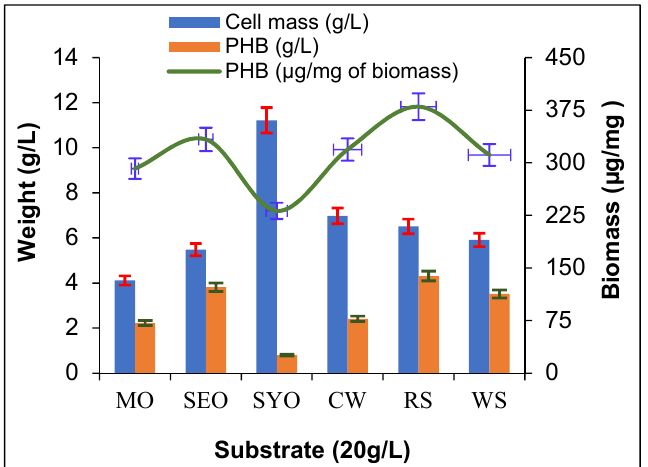
Figure 4. PHB accumulation in A. faecalis RZS4 during 24 h growth at 30 °C and 120 rpm in NDM amended with crude vegetable oil and agro-wastes (20 g/L) as carbon substrates.